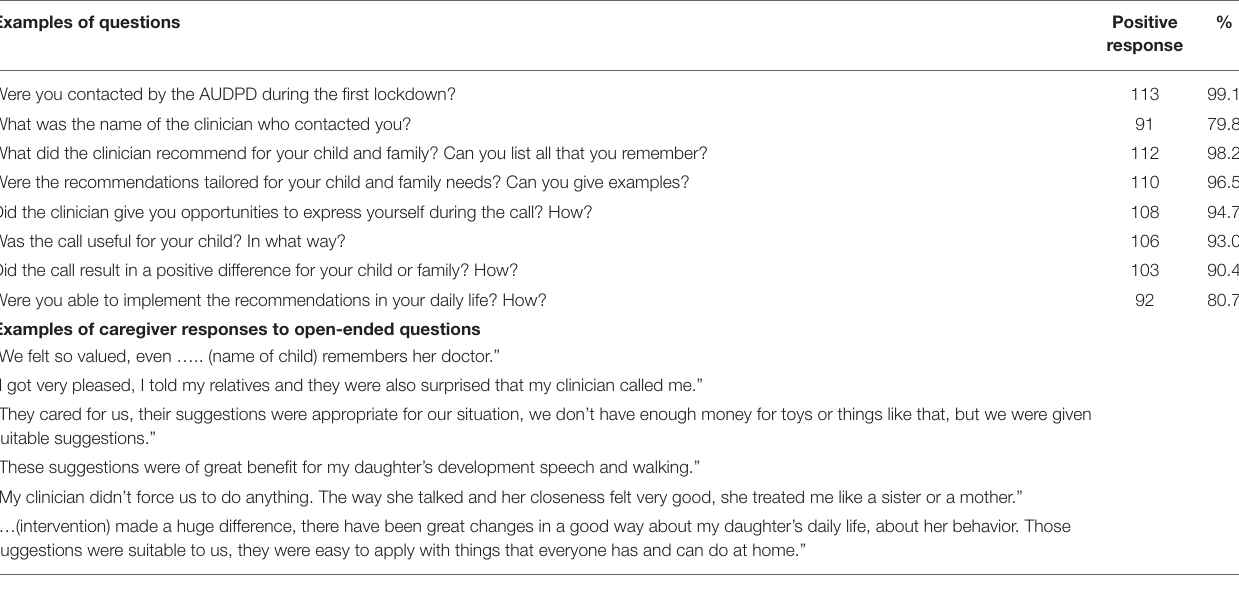
TABLE 2 | Examples from GMCD Applicability Questionnaire ( N =